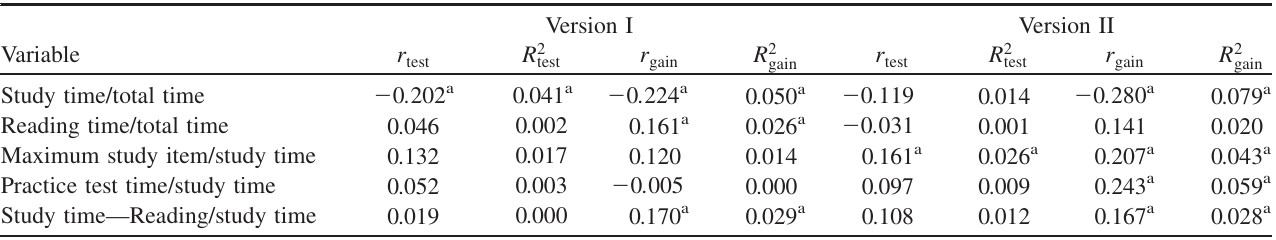
TABLE IV. Division of time on task among activities. For version I, N ¼ 194 students were included, and version II included N ¼ 166 .